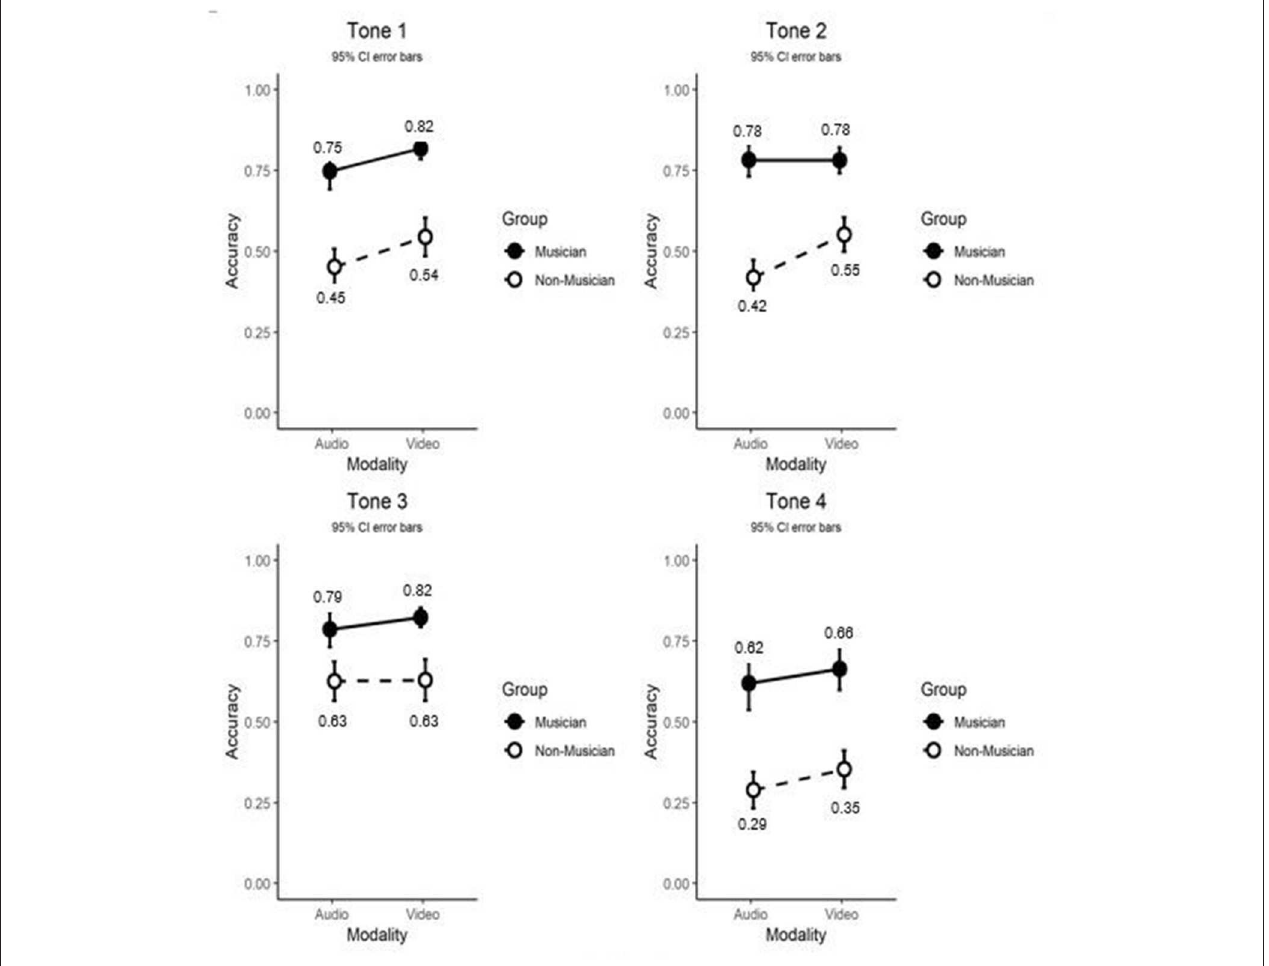
FIGURE 5 | Average accuracy in percentage correct of Mandarin tone identification as a function of modality, musicality and tone. Video represents auditory-visual and Audio represents auditory-only. Error bars represent standard errors. effect of modality [ F (1, 169) = 9.99, p = 0.002], with